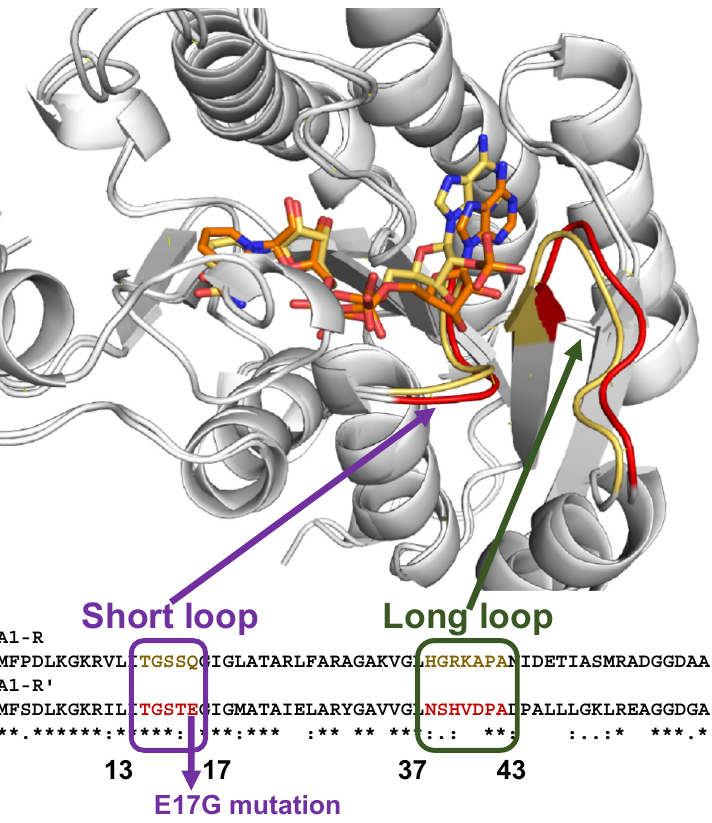
Figure 6. Structural determinants of coenzyme specificity. Two loops (short and long) are crucial for NAD + /NADP + specificity. The two loops in A1-R and A1-R’ are colored yellow and red, respectively. Adaptively evolved yeast ( S. cerevisiae ) transformed with the A1-R’ gene produced the mutant A1-R’ with a Glu-to-Gly substitution at position 17 [9] as described below. Figure from ref. [18] with modifications.